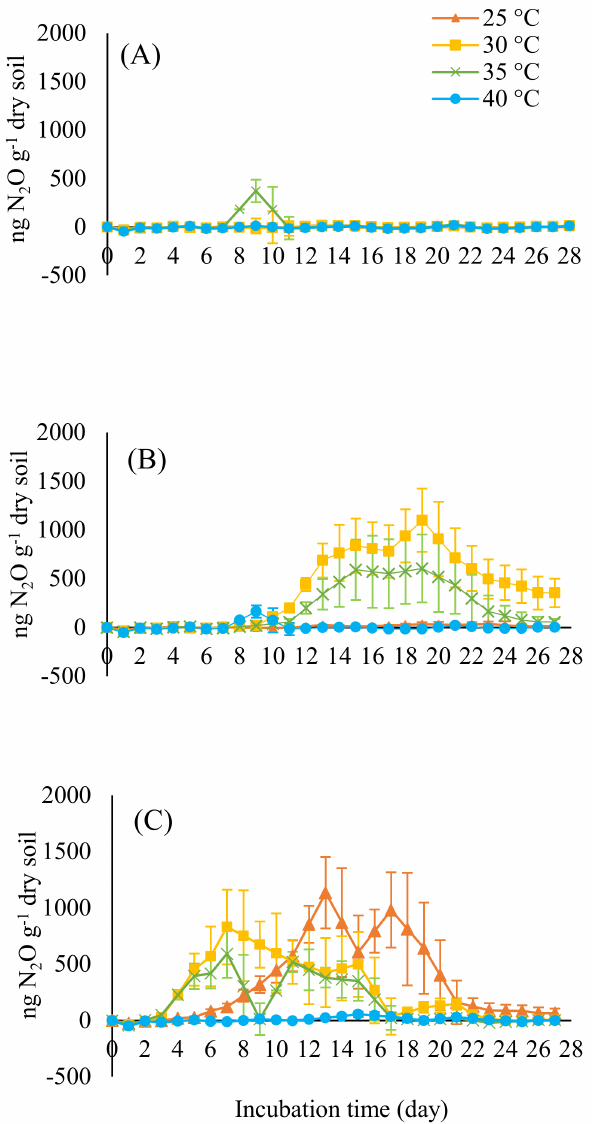
Figure 3. N 2 O fluxes (ng N 2 O g − 1 dry soil day − 1 ) in different land uses ( A ) forest; ( B ) pasture; and ( C ) agriculture in the Brazilian Amazon, incubated at different